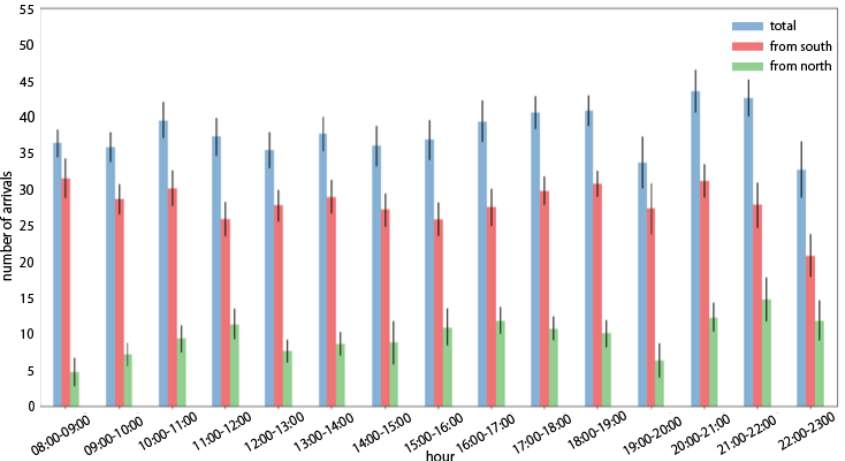
Figure 4. Mean hourly numbers of total arrivals (blue), arrivals from southwest (red), and arrivals from the north (green), during each hour between 08:00 and 23:00, with standard deviations.